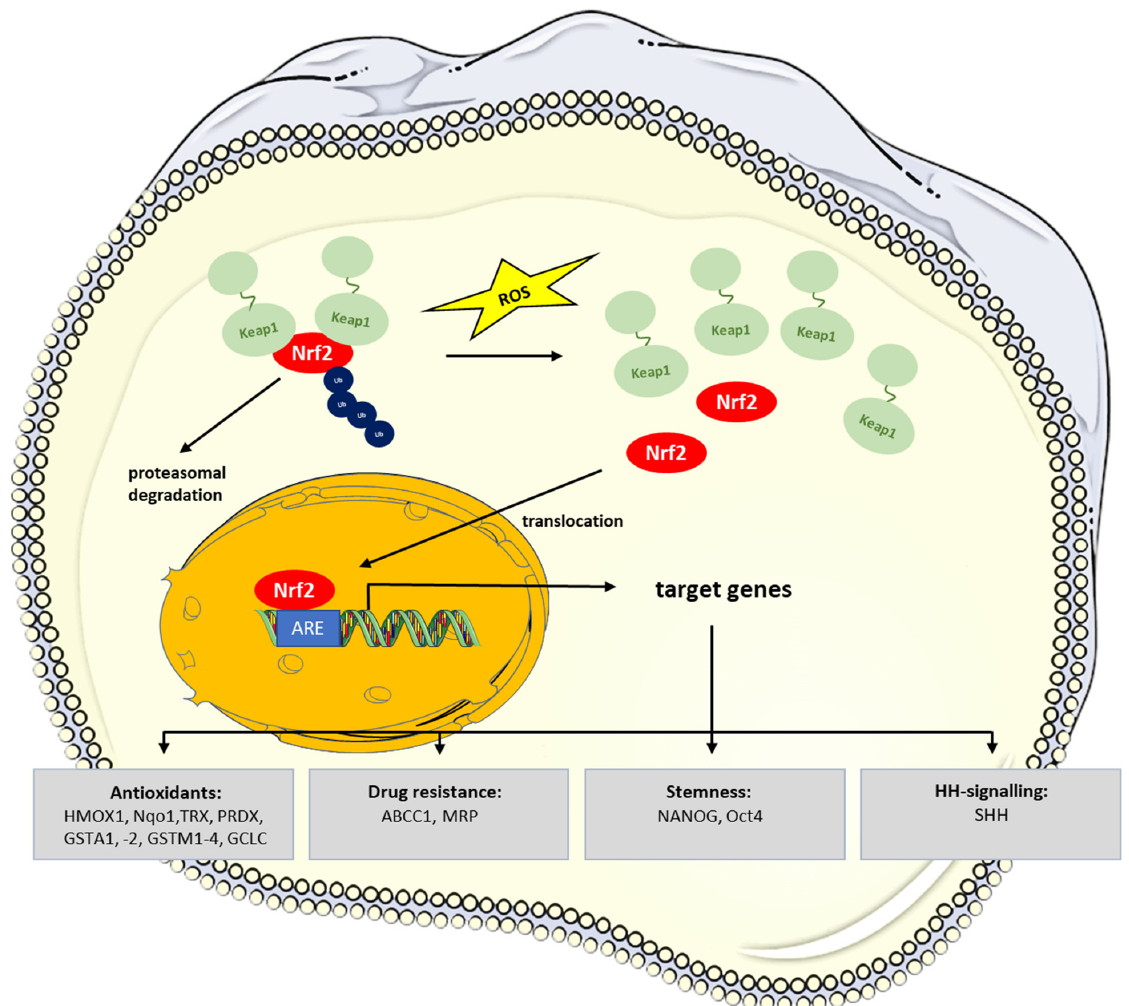
Figure 2. Nrf2 signaling pathway activation by ROS and induction of target genes. Under physio- logical conditions, NRF2 bound to KEAP1 is ubiquitylated and degraded in the proteasome. In re- sponse to ROS and various other stress factors, KEAP1 is released from NRF2, leading to its stabili- zation and translocation into the nucleus. Target gene expression is induced upon binding of NRF2 to AREs (antioxidant response element) in the promoters of target genes. Target genes comprise genes coding for the cell’s antioxidative equipment, efflux pumps enabling drug resistance, stem- ness-regulating transcription factors, as well as SHH (modified from [13,14].